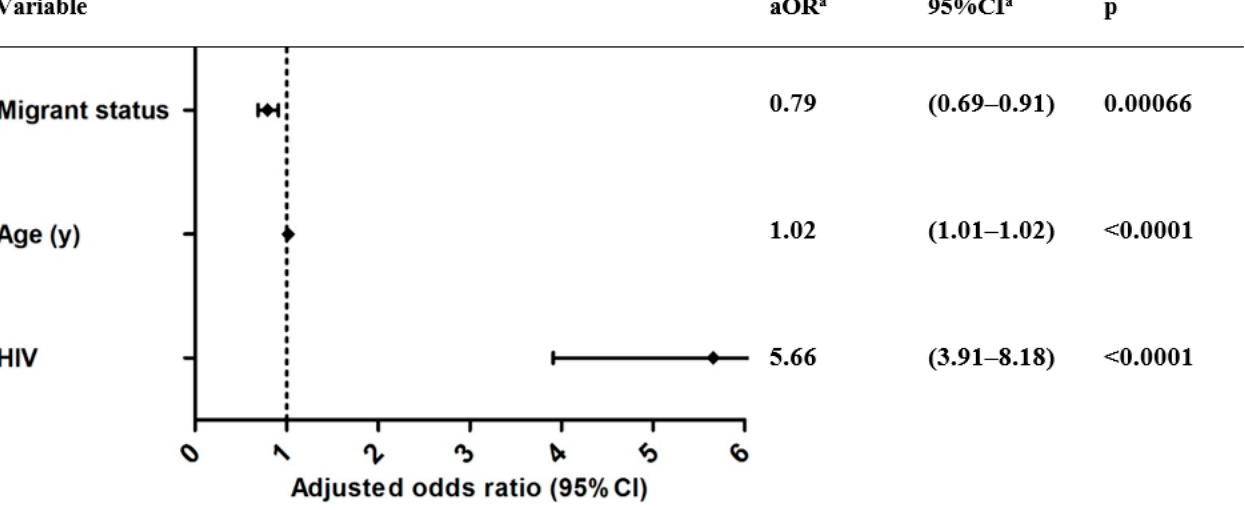
Figure 4. Identification of factors contributing to grade II suboptimal hepatitis HCU. a : OR = odds ratio; CI = confidence interval; aOR = adjusted odds ratio; adjusted for sex, age, migrant status, cirrhosis, diabetes, COPD, malignancy, HIV. Optimal = diagnosed and treated; suboptimal I = diagnosed and followed-up; suboptimal II = only diagnosed.